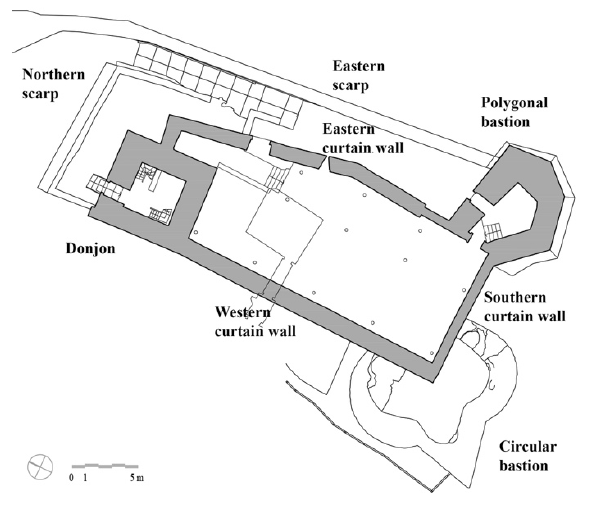
Figure 4. Plan of the Stronghold